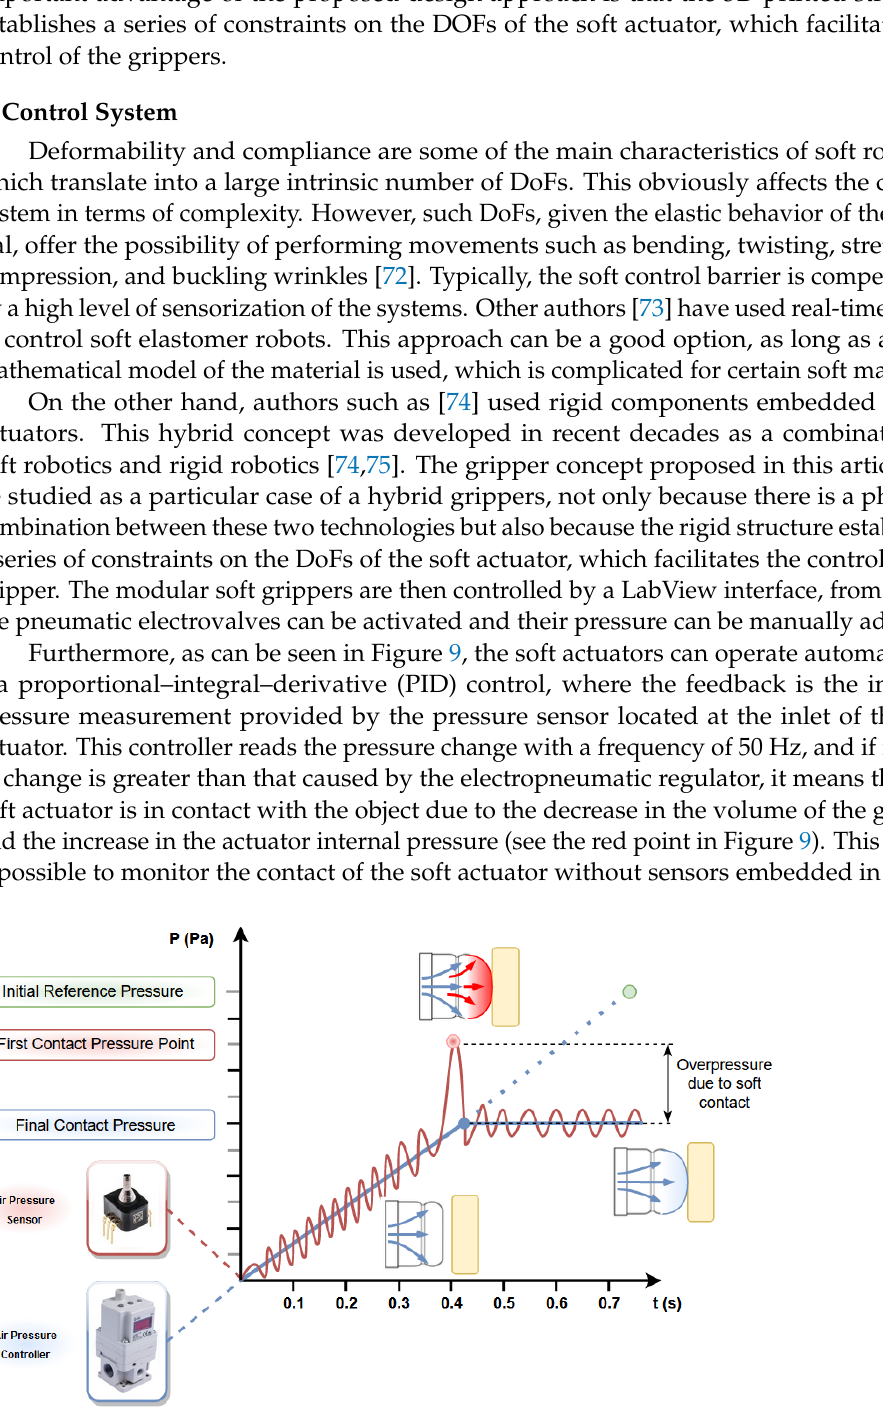
Figure 9. Diagram of the control method for the soft actuator without embedded